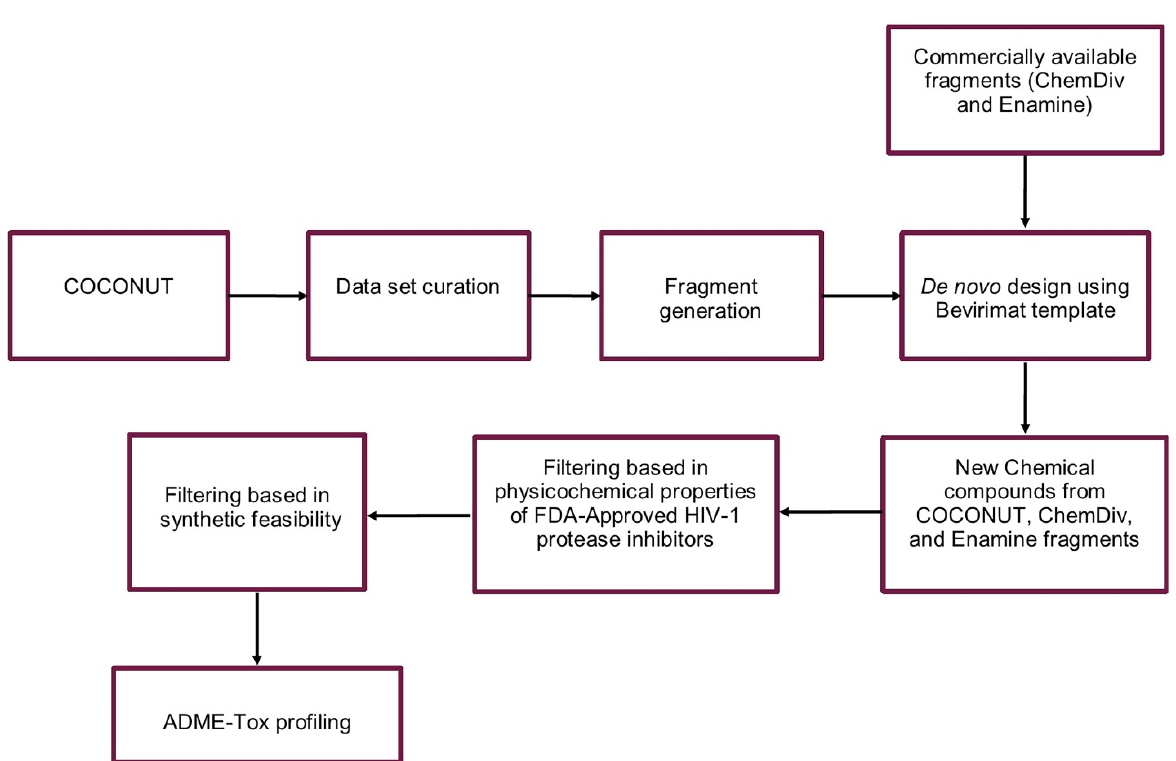
Figure 2. De novo design of the virtual focused compound libraries of HIV-1 viral protease inhibitors from natural product fragments (COCONUT) and commercially available fragments (ChemDiv and Enamine).